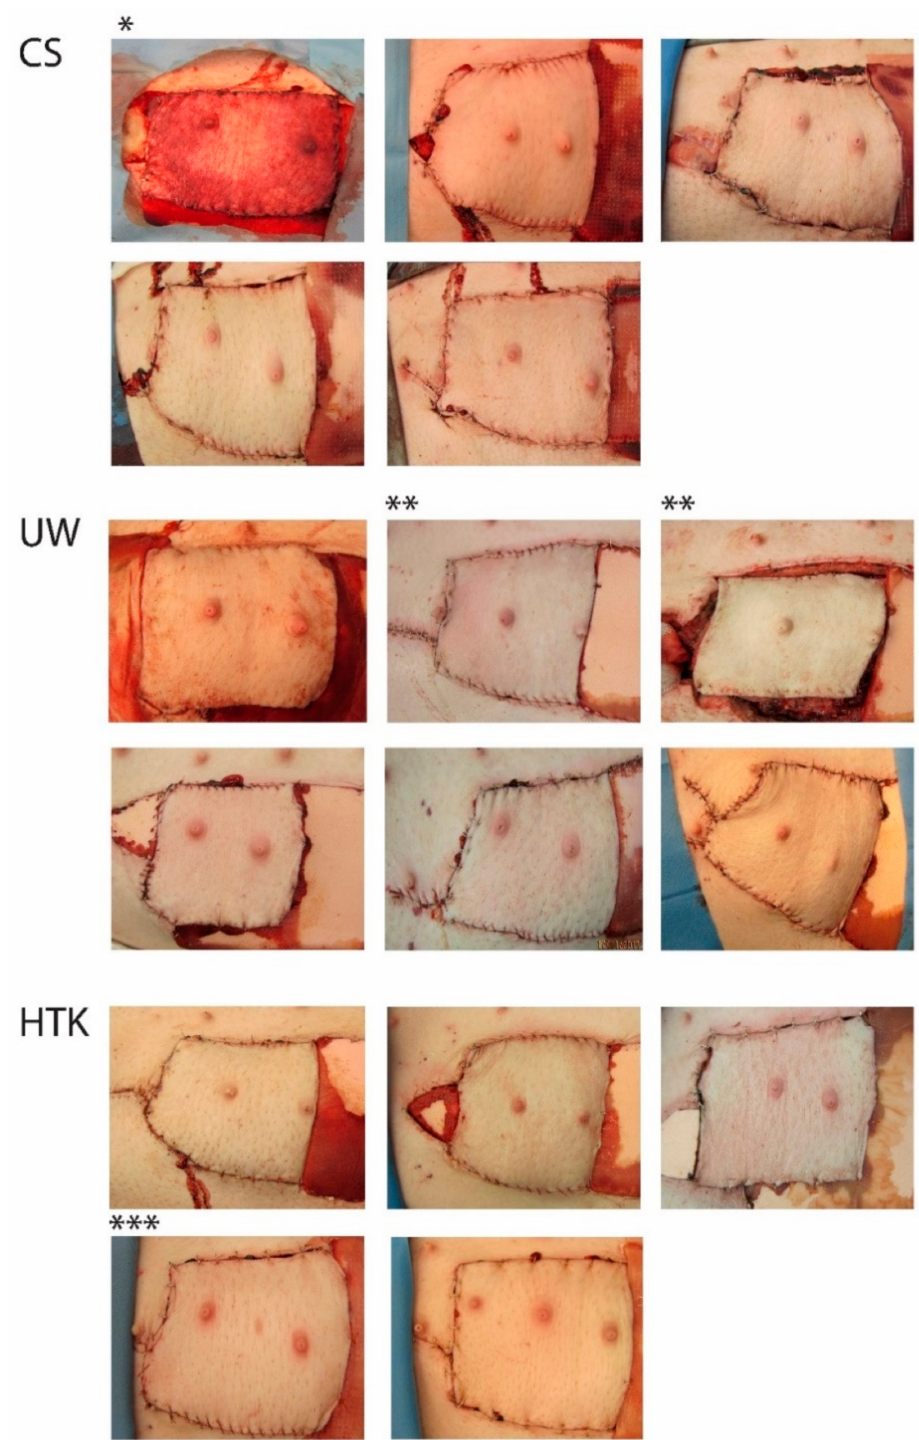
Figure 3. Photographs of all flaps at 12 h after replantation. * Flap 1 was excluded due to therapy- resistant venous congestion and later arterial obstruction. ** Flap 5 at 11 h (left) and 12 h (right) after flap replantation (before and after acute arterial thrombosis). *** Flap 14 underwent successful revision of the arterial pedicle at 8 h after replantation and had normal appearance afterwards. Abbreviations: CS; cold storage, UW; University of Wisconsin solution, HTK; histidine-tryptophan- ketoglutarate